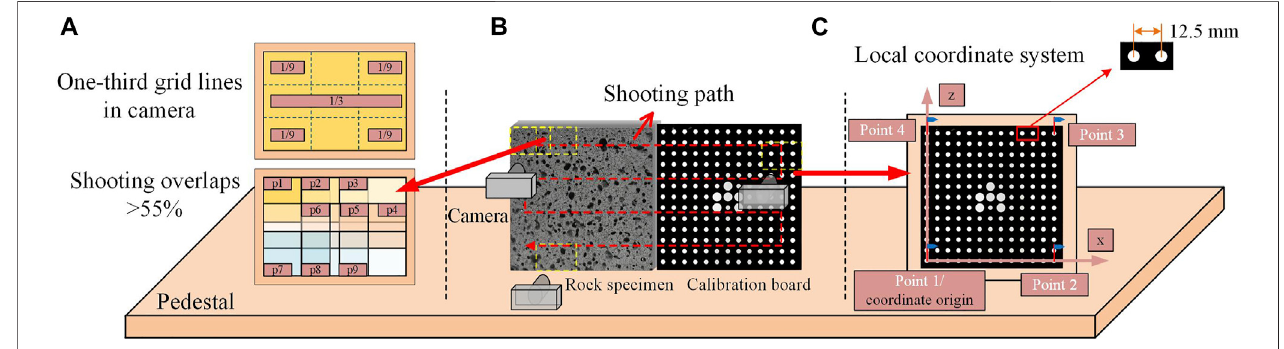
FIGURE 2 | Schematic diagram of the photogrammetry framework: (A) necessary overlaps between the adjacent images both horizontally and vertically; (B) the shooting route and subjects; (C) the calibration board and establishment of local coordinate system.